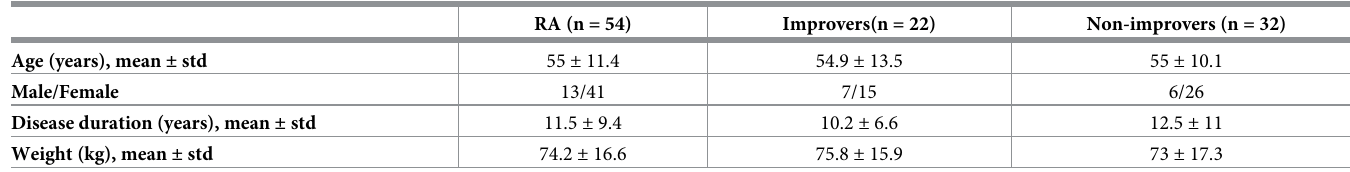
Table 1. Clinical characteristics for the total number of subjects (n = 54) and improvers (n = 22) and non-improvers (n = 32) of fatigue